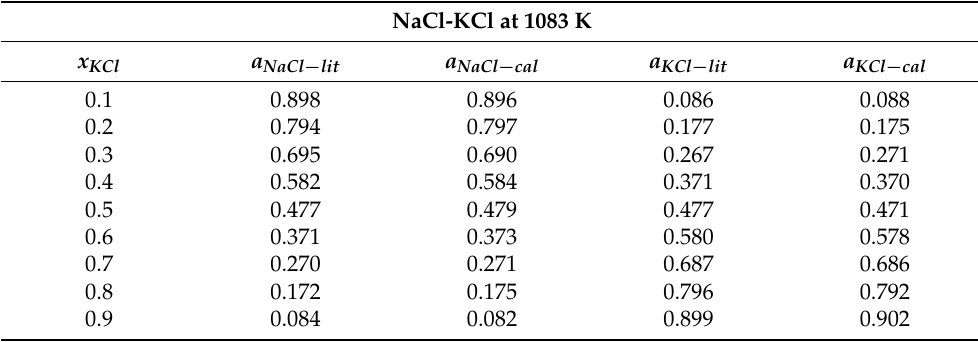
Table 1. Calculated activity values and literature data of the NaCl-KCl binary chloride system at 1083